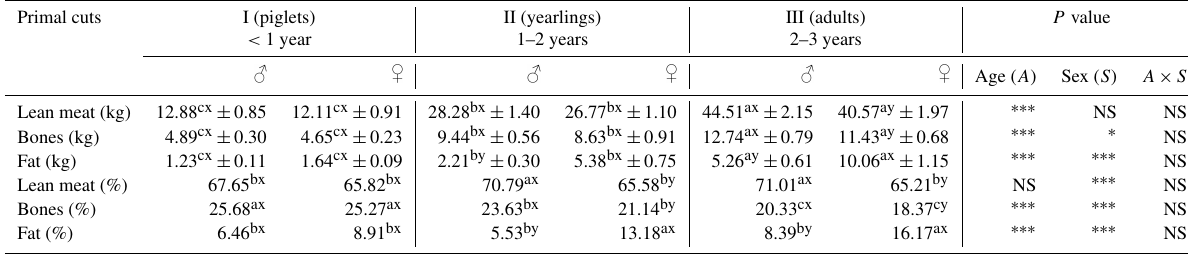
Table 2. Tissue composition of wild boar carcasses in weight and percentage with respect to the carcass weight (mean ± SE). Primal cuts